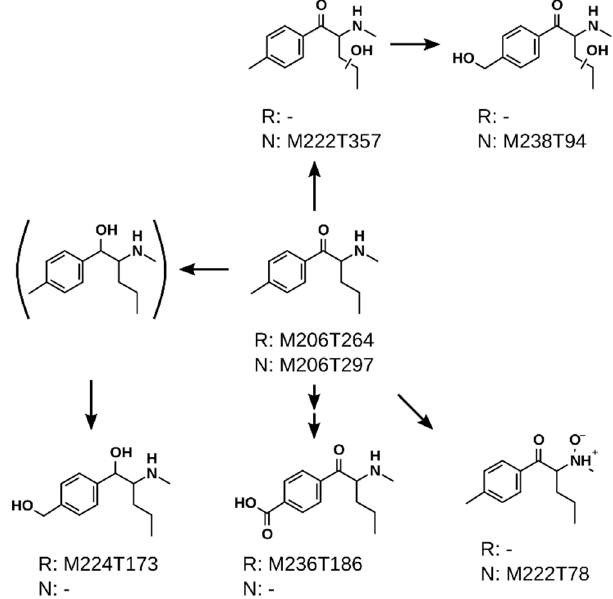
Figure 4. Proposed metabolic pathways of 4-MPD in pHLM. Every metabolite is labeled by its feature identifier as detected within untargeted metabolomics analysis. R = reversed phase chromatography; N = normal phase chromatography. Structure in brackets is a postulated intermediate metabolite.